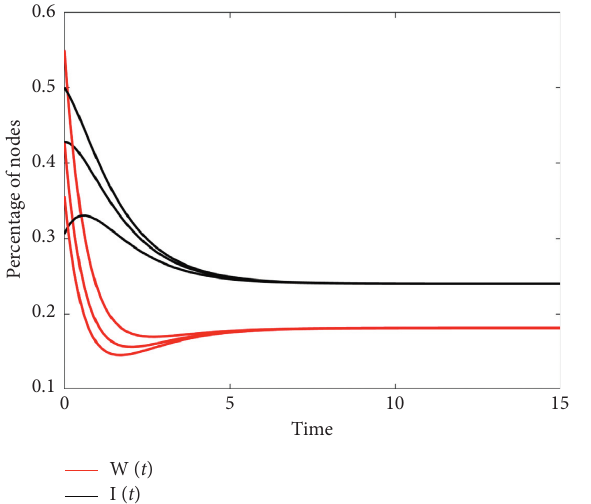
Figure 3: Time plot of model (5) with parameters and initial conditions set as in Example